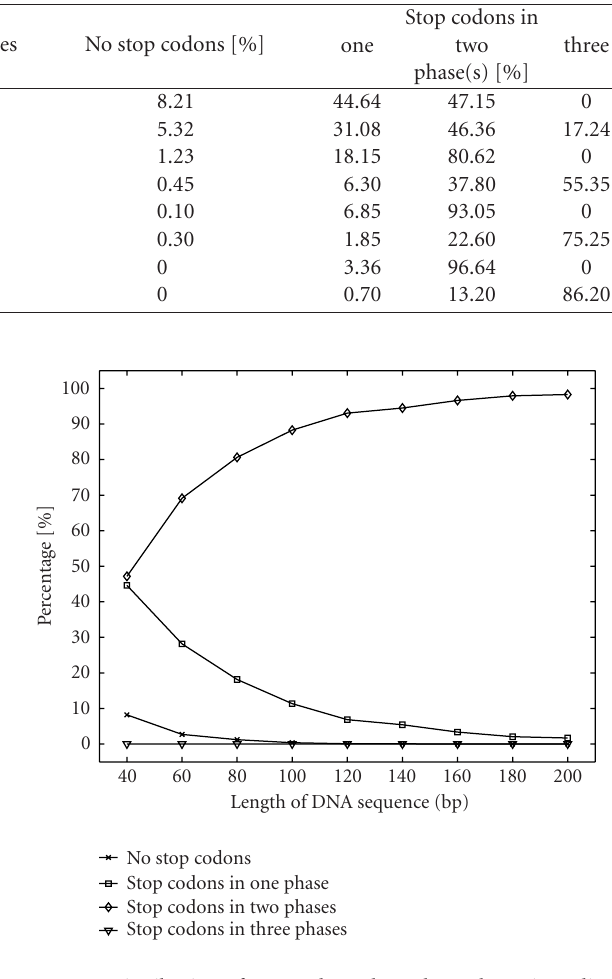
Figure 2: Distribution of stop codons along three phases in coding DNA